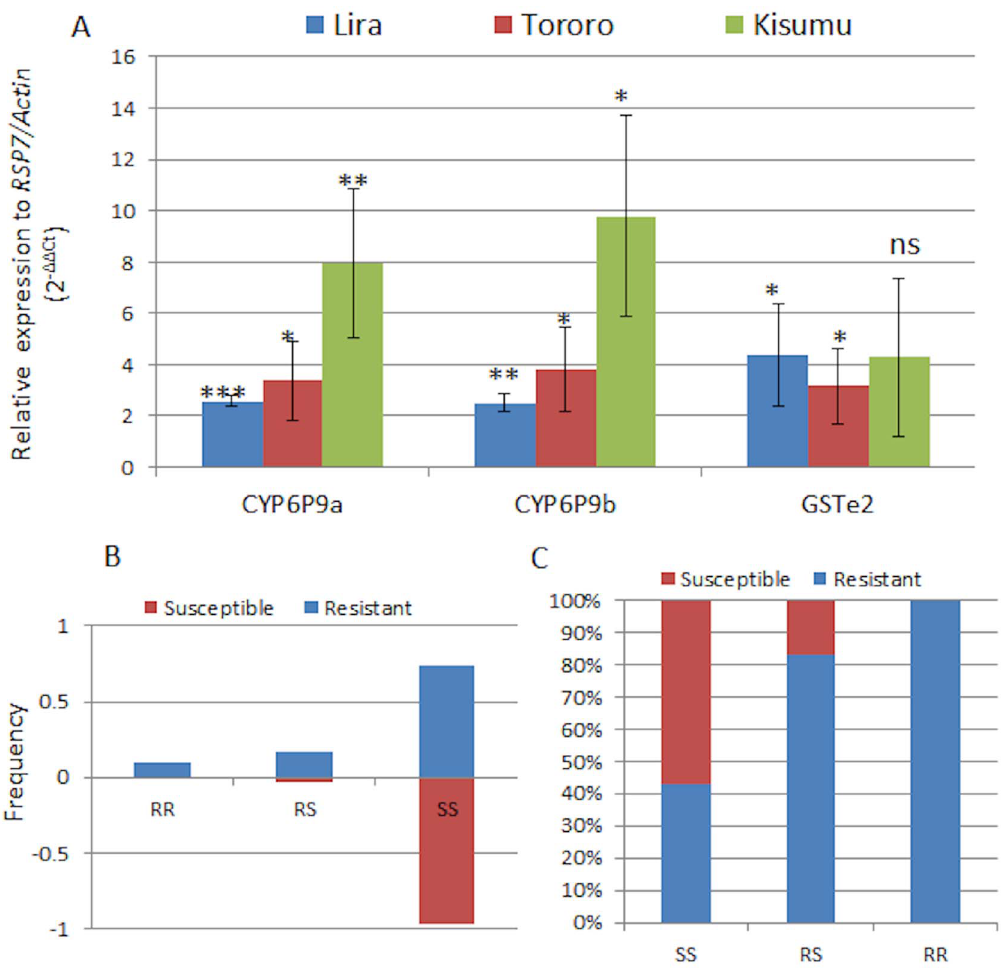
Figure 6. Investigation of metabolic resistance mechanisms. (A) Differential expression of candidate resistance genes by qRT-PCR between resistant mosquitoes (Lira, Tororo and Kisumu) and the susceptible FANG strain; Error bars represent standard deviation (n=3). *** P , 0.001; ** P , 0.01; *P , 0.05; ns not significant. (B) Correlation between the L119F alleles and DDT resistance phenotype. (C) Genotype distribution of L119F mutation between DDT resistant and susceptible